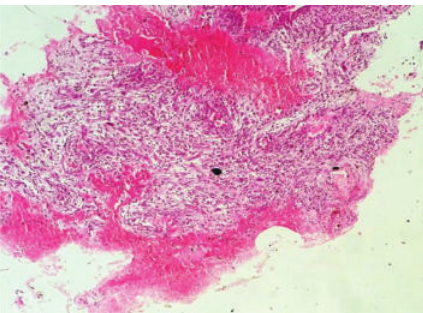
Figure 4: H&E 10x view showing vascular stroma with proliferation of spindle cells intermixed with extravasated